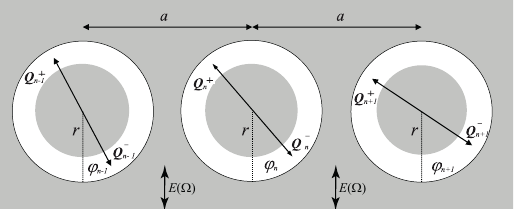
Figure 1. Schematic representation of the model system in the form of the chain of non-point dipole oscillators of diameter 2 r with spacing a where the oscillations of the charges in the shells (the real thickness of which can be about ∼ 10–100 ) around nanoscale particles are shown. The direction of the action of the alternating electric field E ( Ω ) is denoted by